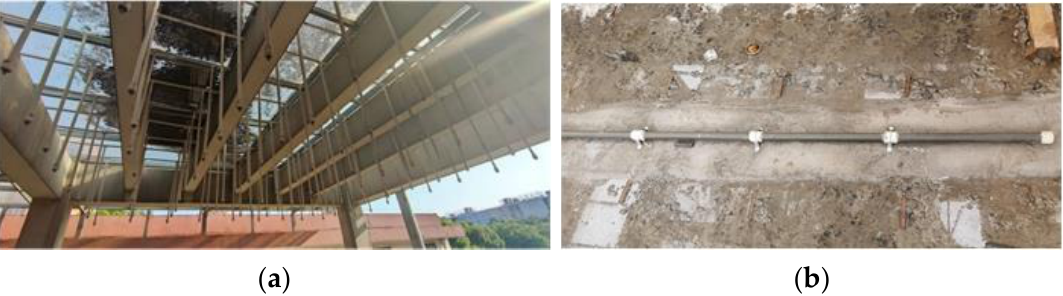
Figure 3. Details of rainfall and groundwater equipment ( a ) Rainfall equipment ( b ) Groundwater simulation equipment.